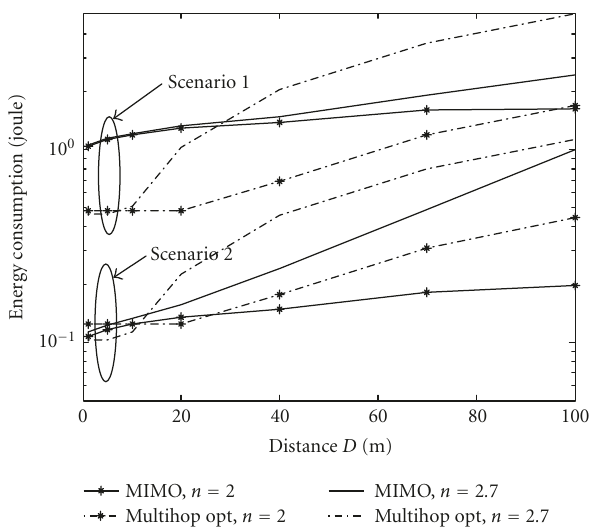
Figure 4: Total energy consumption versus D when ρ s = 0 . 01 ( M = 100) and n = 2 . 0, n = 2 .